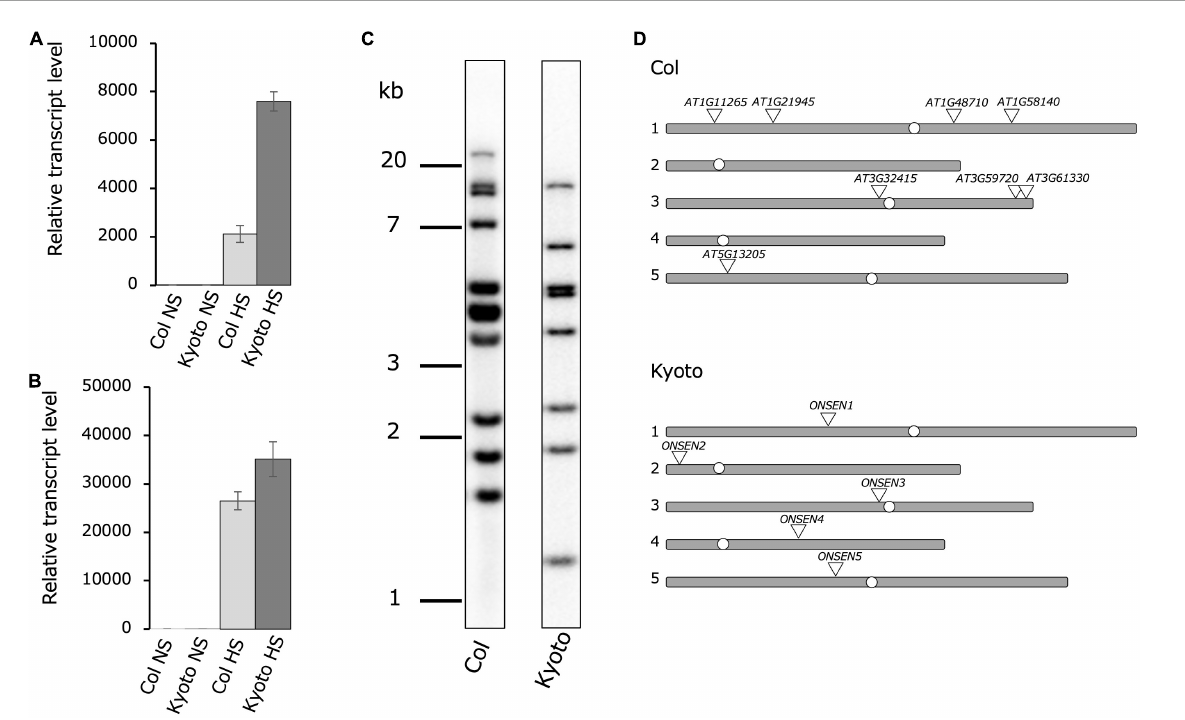
FIGURE1 Comparison of ONSEN features in Col-0 and Kyoto. Real-time reverse transcription polymerase chain reaction showing relative ONSEN (A) and HSFA2 (B) expression under heat stress (HS) and non-stress control (NS) conditions. All bars represent means ± SD from three biological replicates. Values shown are relative to those of Col-0 NS (set to 1). Relative ONSEN transcription levels were first normalized to 18S rRNA and then to Col-0. (C) Southern blot of ONSEN in Col-0 and Kyoto. (D) Chromosomal locations of ONSEN in subtypes based on sequencing of chromosomes 1–5.